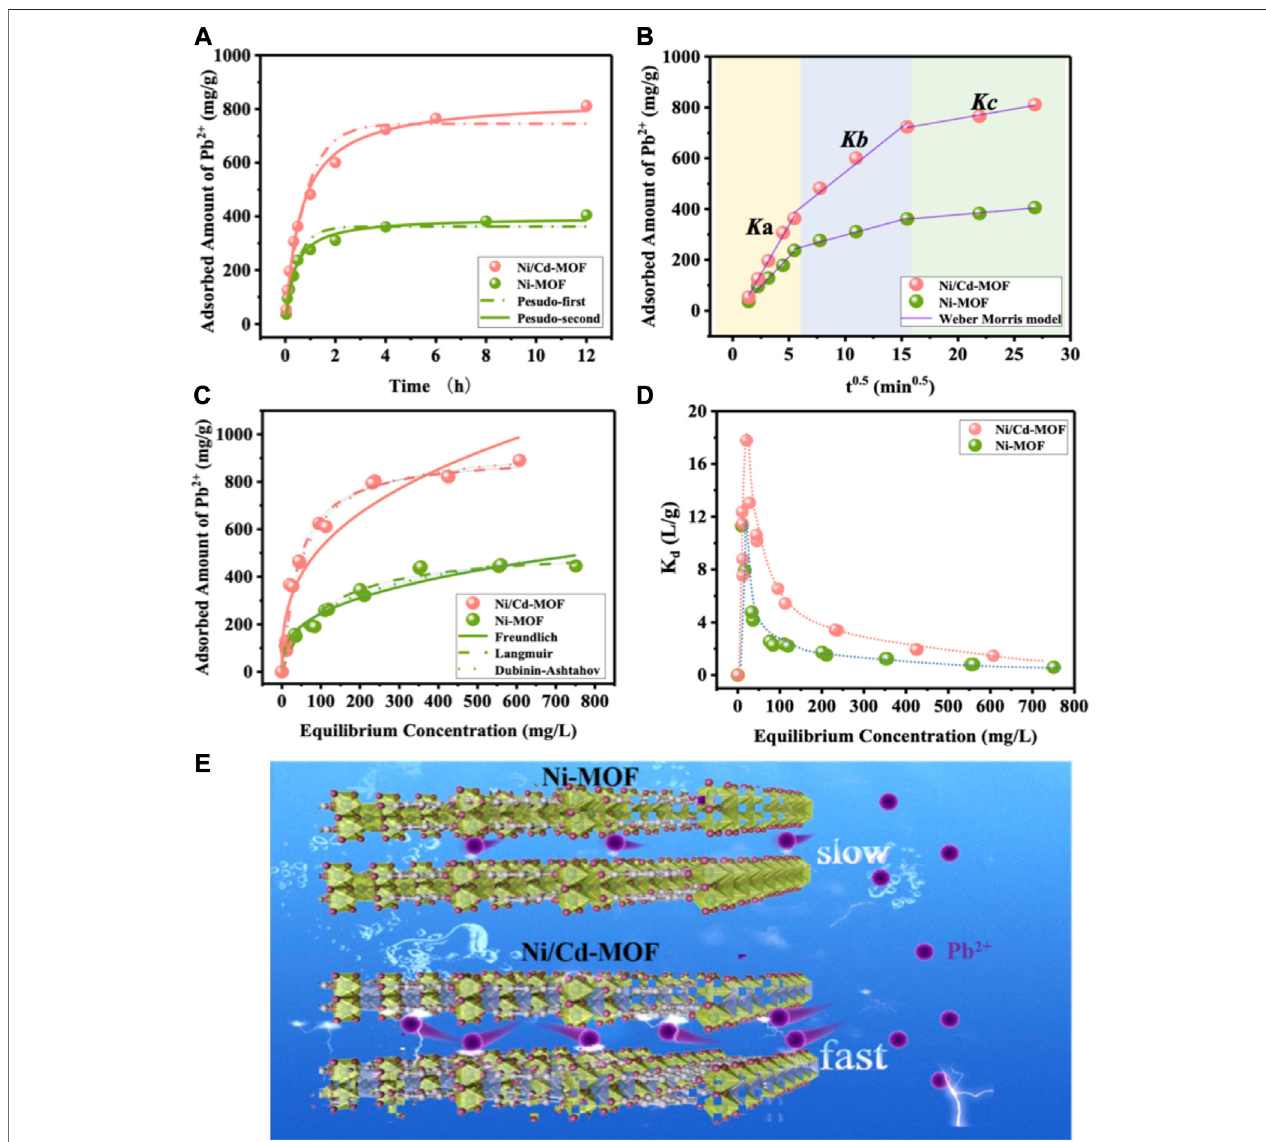
FIGURE 7 | (A) Adsorption kinetic curves of Pb 2+ onto Ni-MOF and Ni/Cd-MOF, and their corresponding model fi tting curves (equilibrium pH: ∼ 5.1 without any adjustment); (B) diffusionmodel fi ttingcurvesofPb 2+ onNi-MOFandNi/Cd-MOF; (C) adsorptionisothermsofPb 2+ ontoNi-MOFandNi/Cd-MOF,andfourmodel fi tting curves; (D) thevariationinthepartitioncoef fi cient( K d )withtheequilibriumconcentrationfortheadsorptionofPb 2+ ontoNi-MOFandNi/Cd-MOF; (E) schematicdiagram of different adsorption behaviors of Pb 2+ onto Ni-MOF and Ni/Cd-MOF.